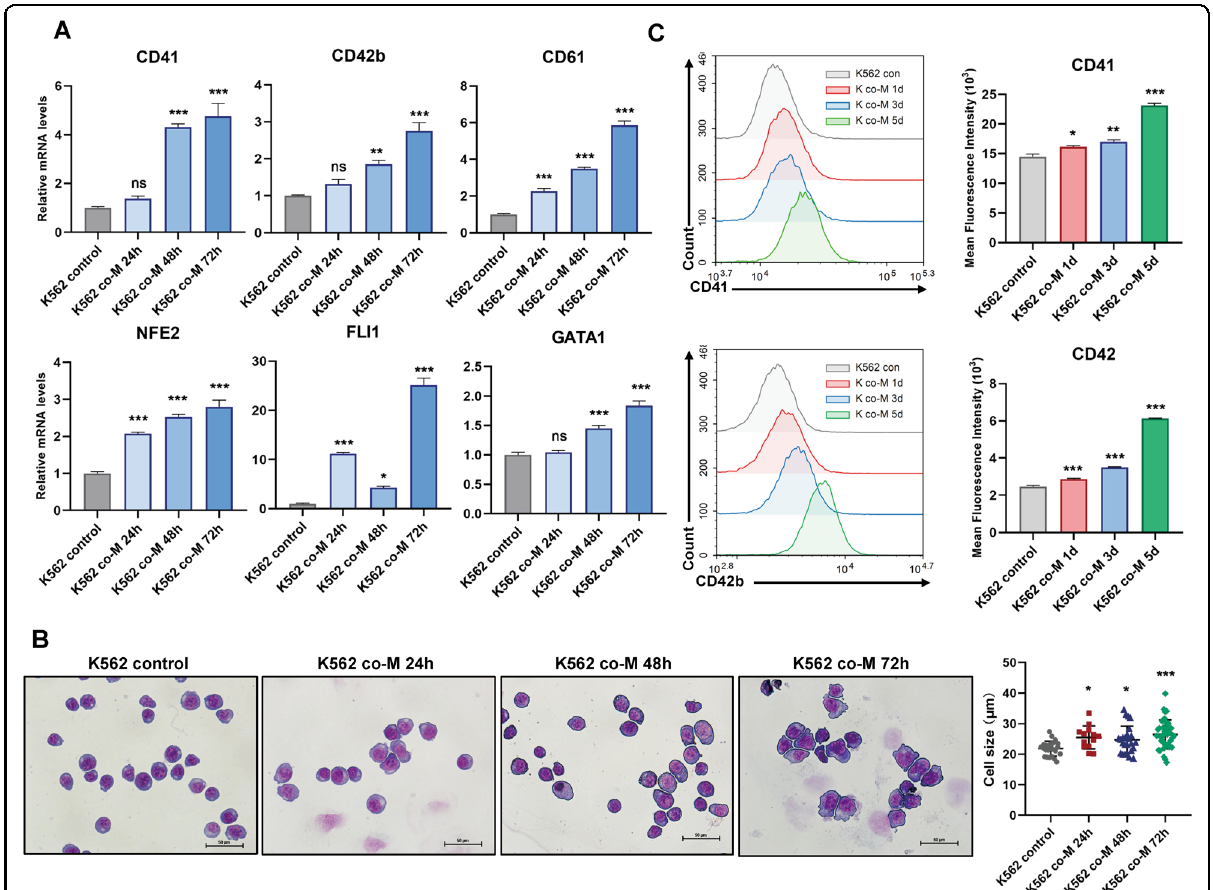
Fig. 2 MSCs-induced profound differentiation in CML cell line. A K562 cells were cultured alone or co-cultured with MSCs for different times. The relative mRNA levels of differentiation genes and transcription factors were assessed by RT-qPCR ( n = 3). B Morphological changes accompanied by megakaryocytic differentiation were con fi rmed by Wright – Giemsa staining of cells with or without MSCs culture. Scale bars, 50 μ m. Comparison of the cell size in K562 cells prior to or after stimulation by MSCs. C The amounts of cell surface protein CD41 and CD42b were measured by fl ow cytometric. The amounts of K562 cell surface proteins were expressed as the geometric mean fl uorescence intensity. All statistical data in this fi gure represented the mean ± SEM (* P <0.05, ** P <0.01, *** P <0.001, ns, not signi fi cant, one-way ANOVA for multiple comparisons). M